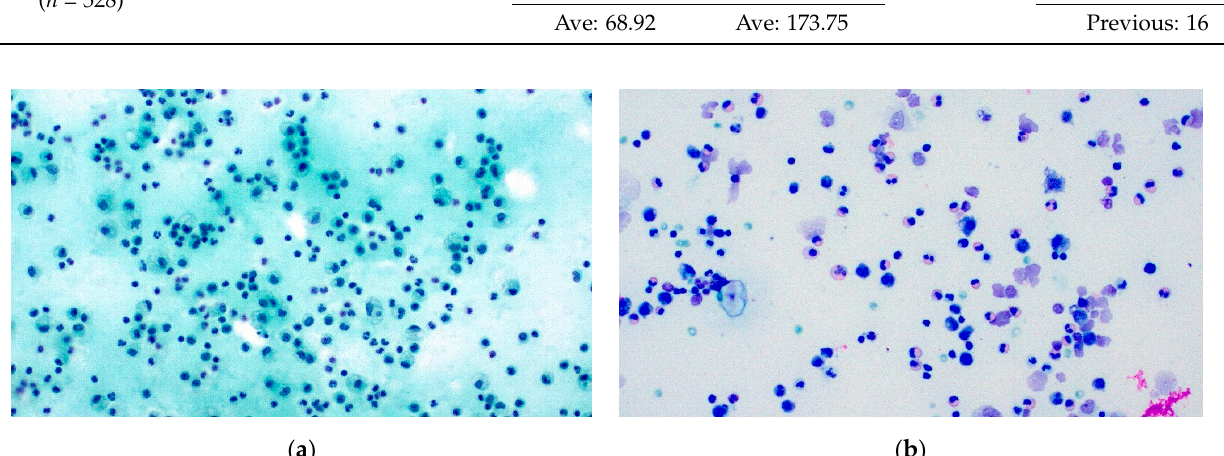
Figure 1. Pleural effusion NFM (TIS2). ( a ) Reactive effusion, Pap stain ×200, and ( b ) eosinophilic effusion, Giemsa stain ×200.